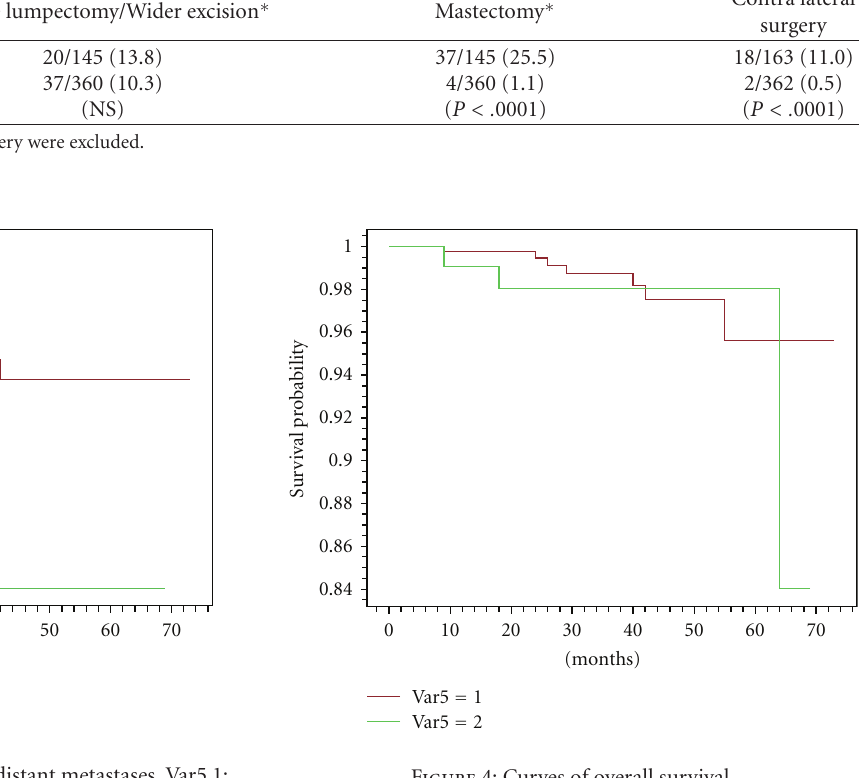
Figure 4: Curves of overall survival. Table 8: Site and number of first failure after